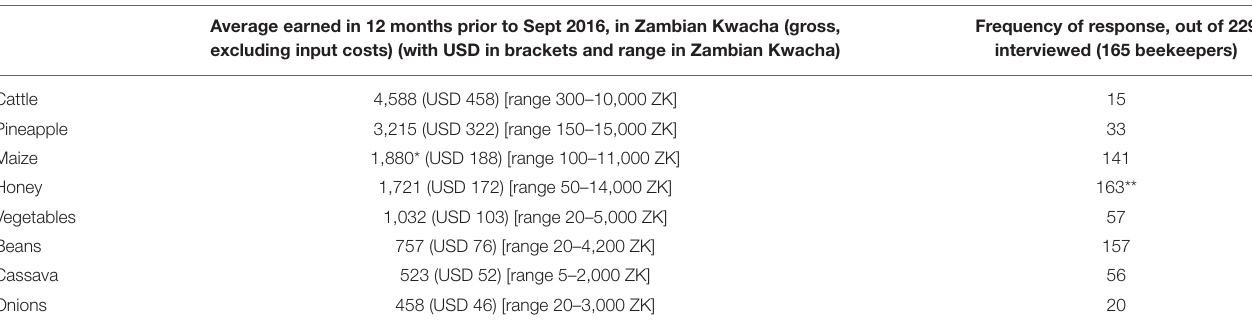
TABLE 3 | Average income earned from honey and other